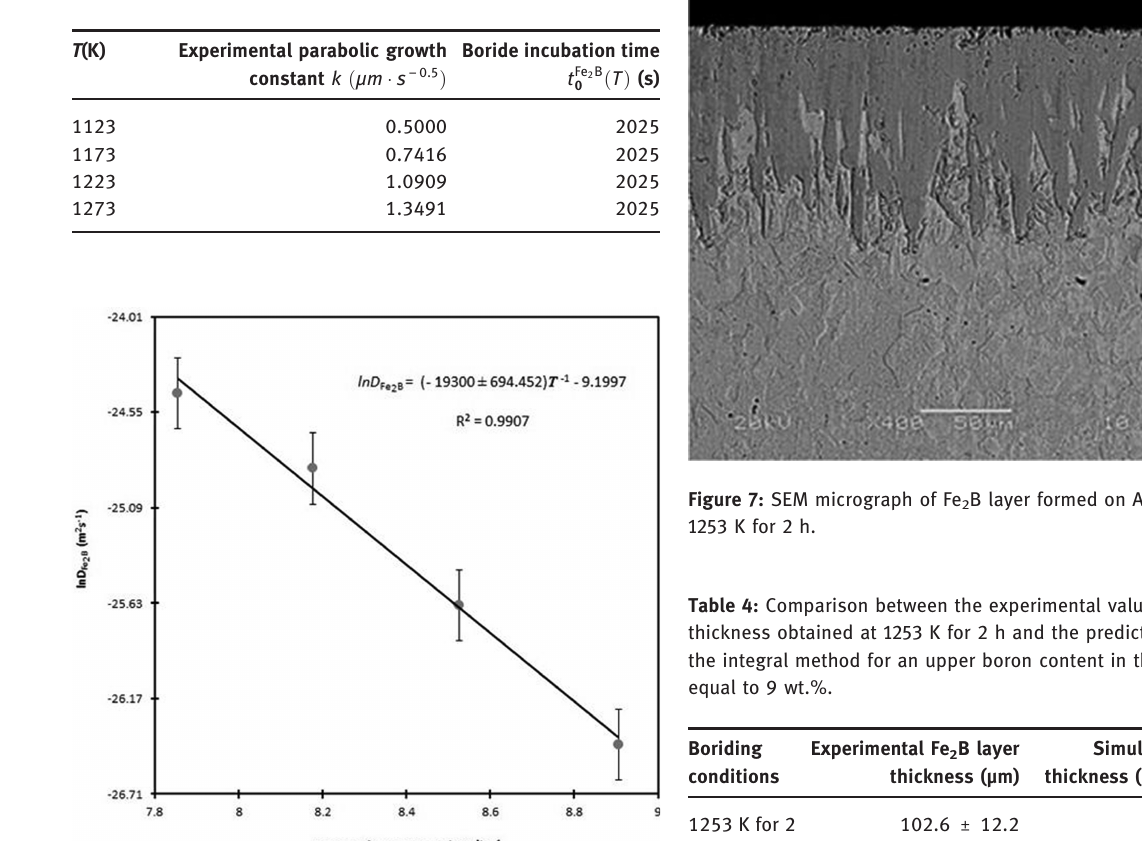
Table 2: The experimental values of parabolic growth constants at the (Fe 2 B/substrate) interface along with the corresponding boride incubation times.